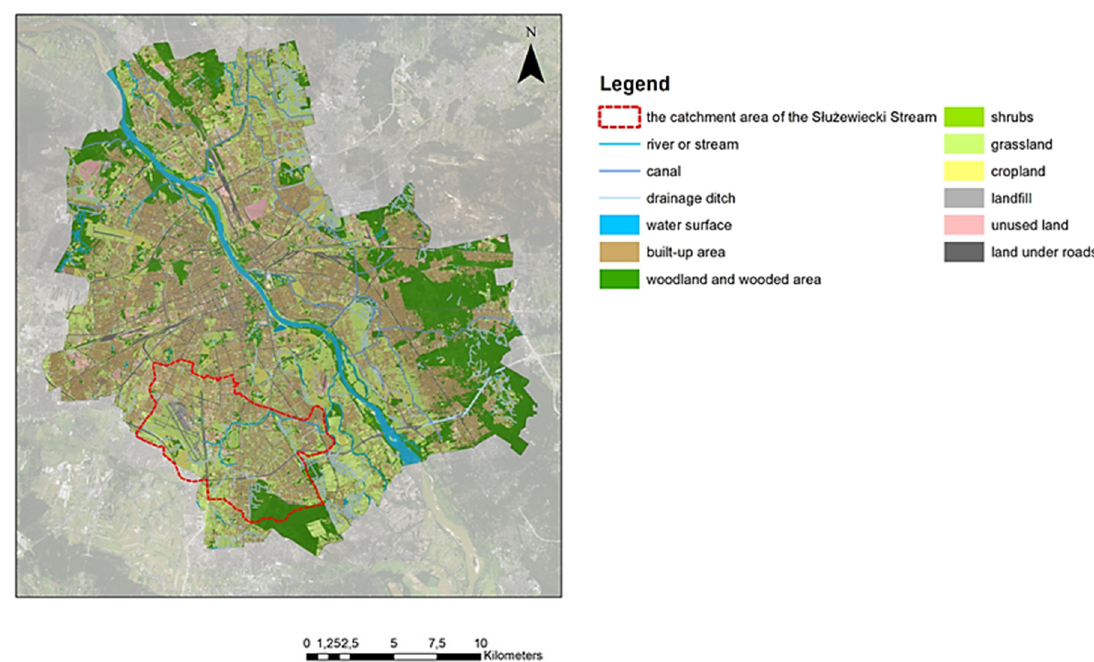
Figure 7. Digital Elevation Model (DEM) and slope (% rate) map for the city of Warsaw.